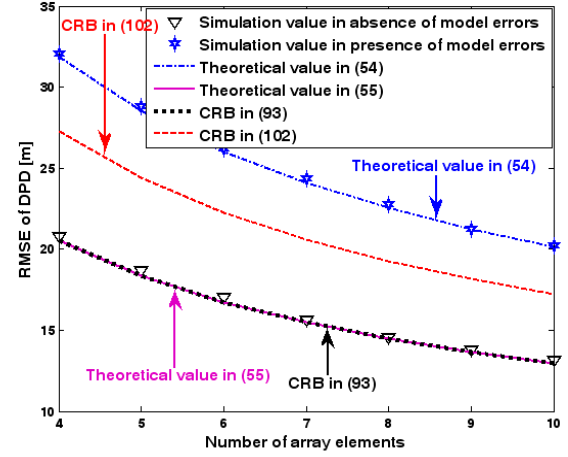
Figure 9. RMSE of DPD as a function of standard deviation of sensor gain perturbation.